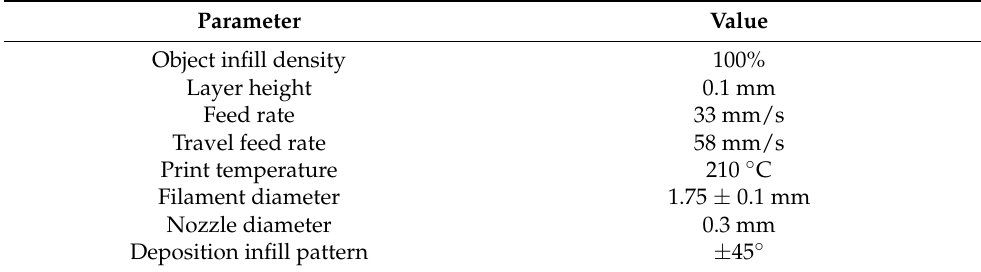
Table 1. FDM parameters used in this